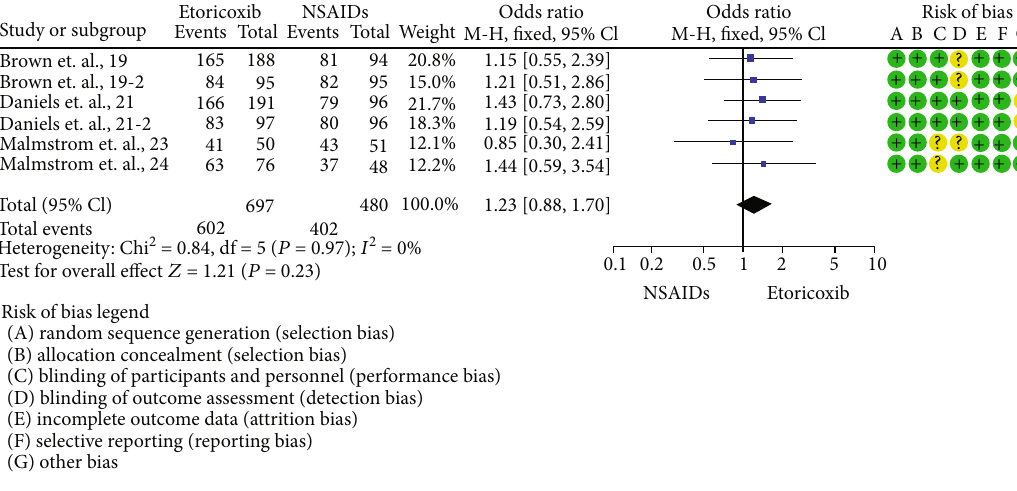
Figure 5: Global assessment of the study medication.